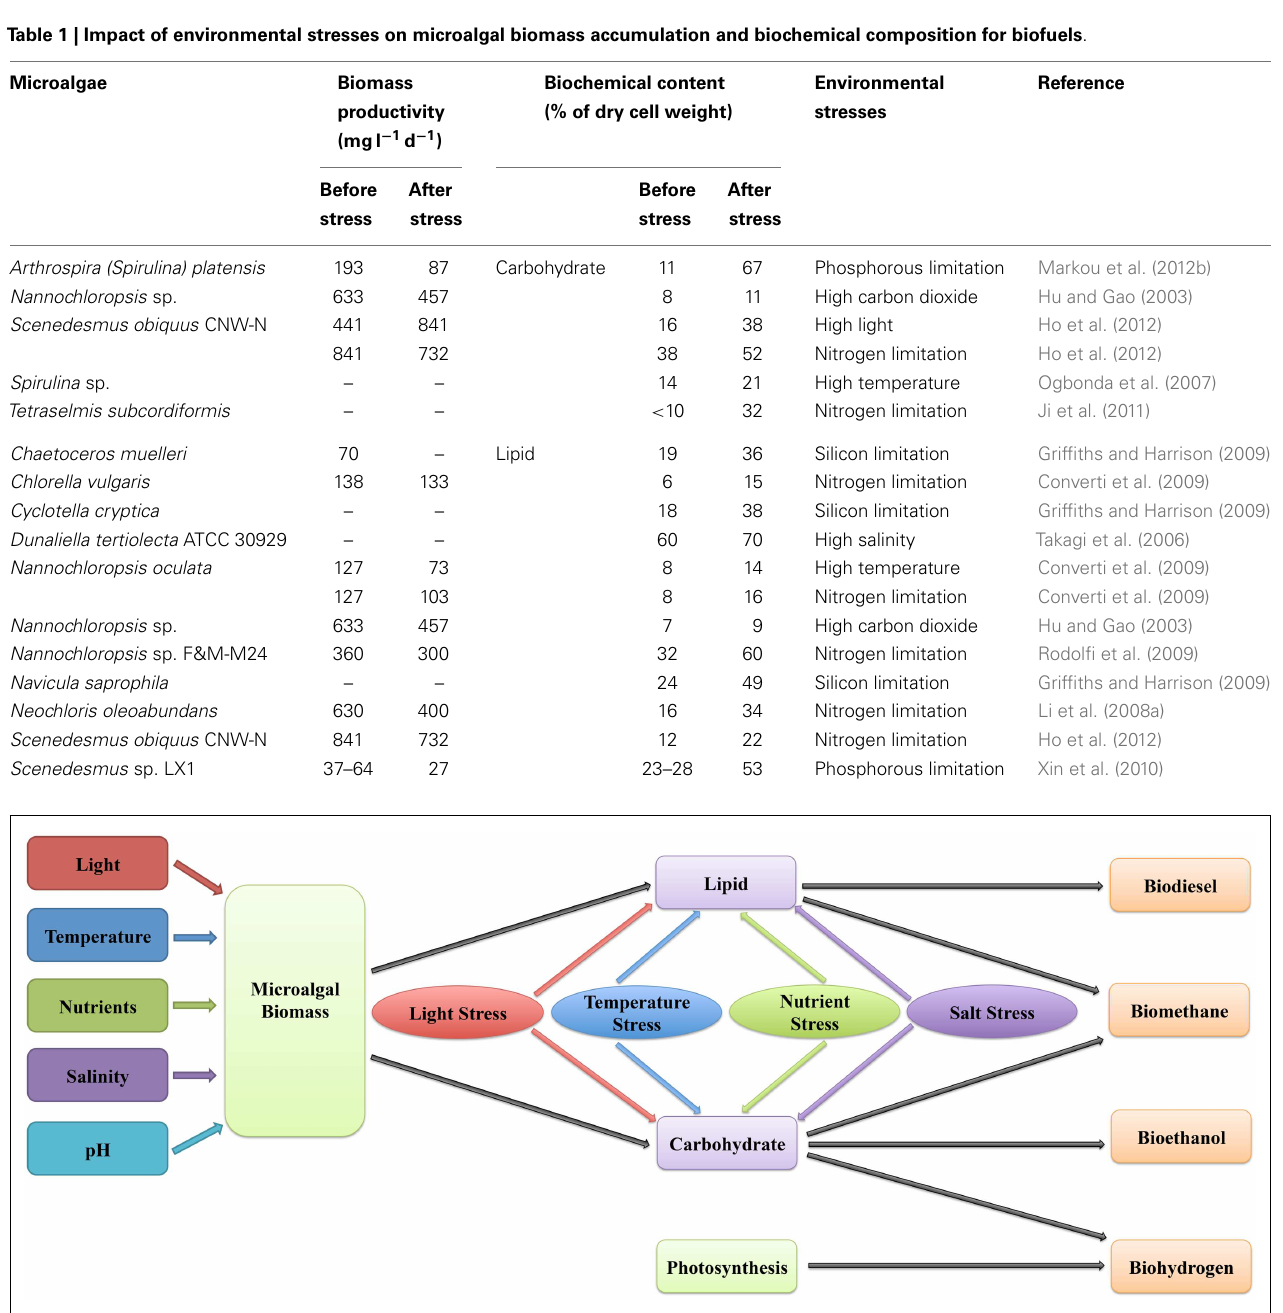
FIGURE 1 |A model for environmental control of microalgal biomass accumulation and biofuel production is shown . Environmental factors, such as light, temperature, nutrient, salinity, and pH affect microalgal biomass accumulation.The biomass-derived lipid and carbohydrate can be